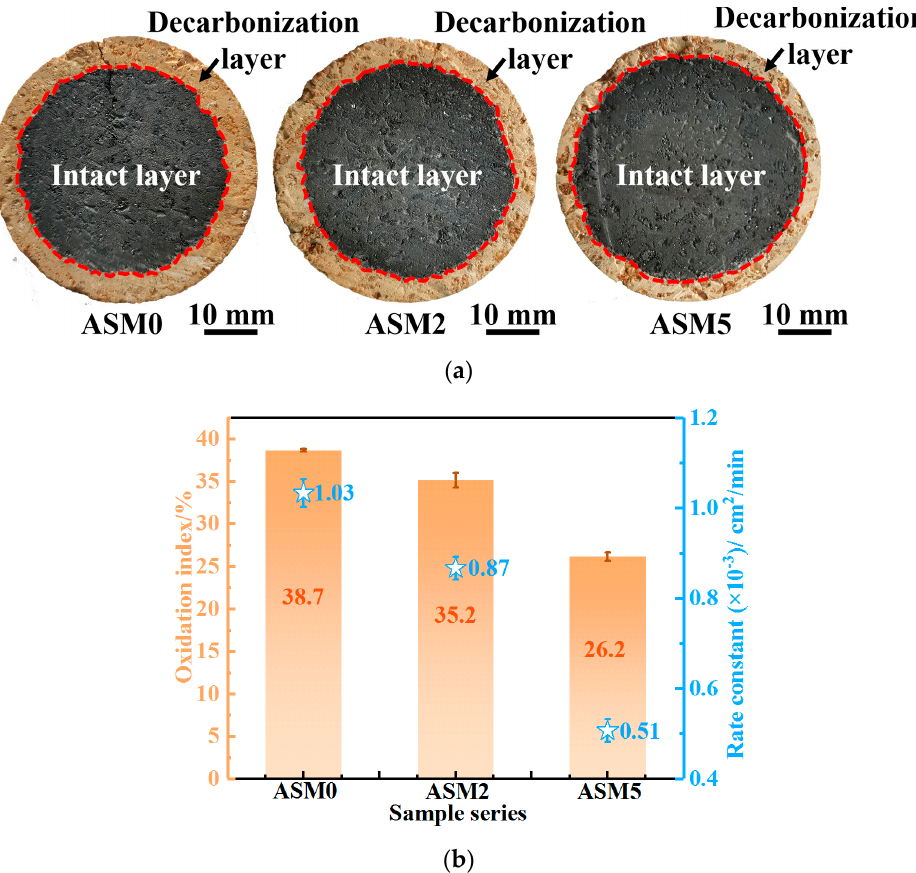
Figure 2. Cross-sectional views ( a ), oxidation index, and rate constant ( b ) of the low-carbon MgO-C refractories fired at 1500 °C.